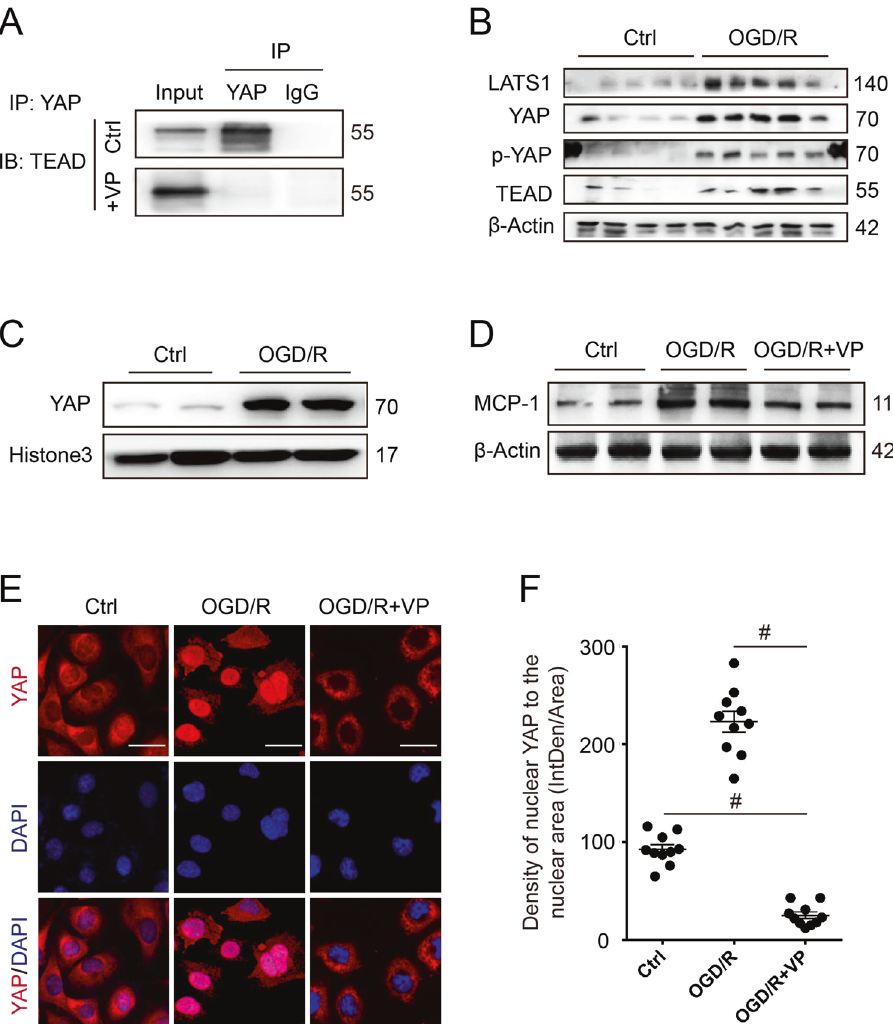
Fig. 6 The impact of oxygen-glucose deprivation and reoxygenation (OGD/R) injury on Hippo-YAP pathway and MCP-1 in vitro. A The effect of vertepor fi n (10 µM) on binding interaction between YAP and TEAD in vitro. B Cellular expressions of Hippo core proteins (LATS1, YAP, p-YAP[ser127], and TEAD) in HK-2 cells treated with oxygen-glucose deprivation and reoxygenation (OGD/R) injury. C Nuclear expression of YAP in HK2 cells after OGD/R treatment. D The effect of vertepor fi n on MCP-1 expression in HK-2 cells after OGD/R. Shown are representative blots from at least three separate experiments with similar results. E Representative images of immuno fl uorescent staining for YAP in vertepor fi n treated HK-2 cells after OGD/R. F Semi-quanti fi cation of nuclear YAP expression in immuno fl uorescent staining ( n = 10 randomly captured images per group). Scale bar = 20 µm in all images of E . All values are means ± SEM. # p < 0.001 de fi ned as signi fi